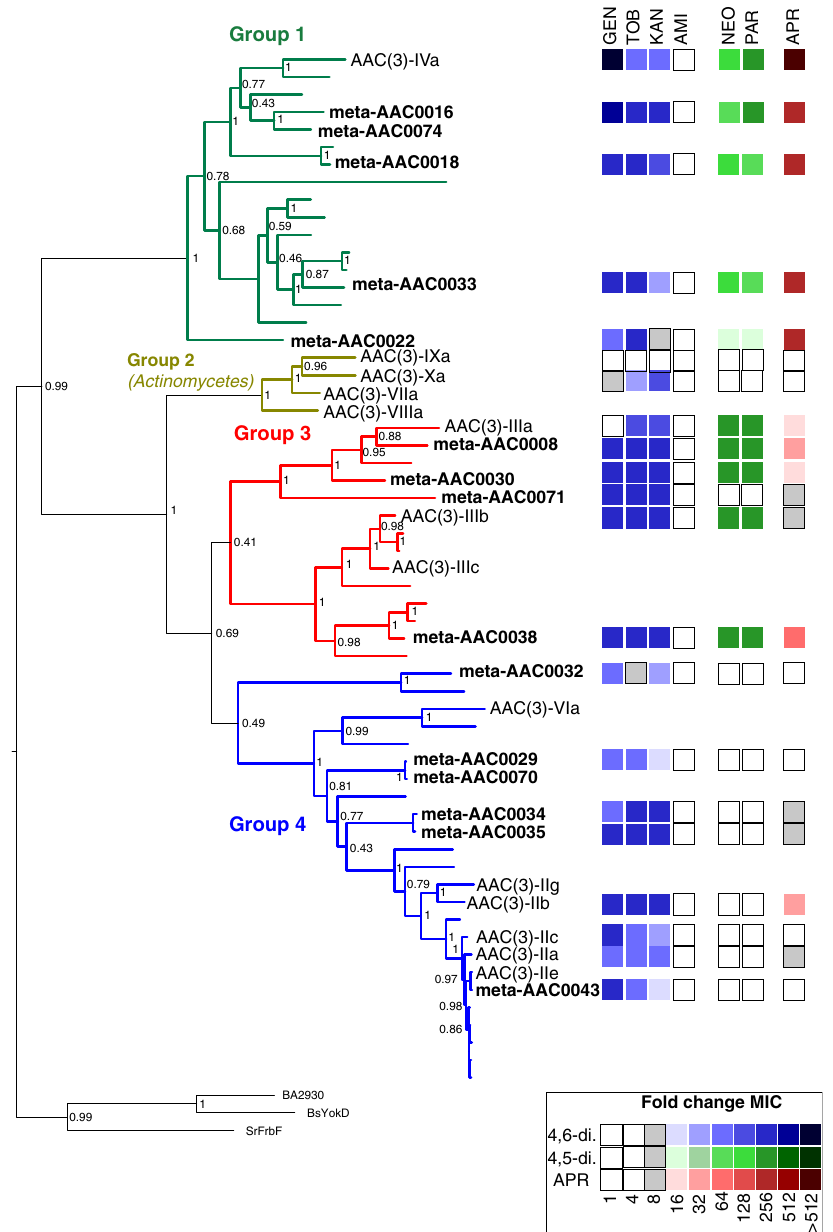
Fig. 2 Family-wide antibiotic susceptibility mapped onto phylogenetic reconstruction of Antibiotic_NAT family. The four main groups are separately colored. Sequence names are only shown for meta-AAC, clinical isolates of AAC(3) enzymes, and outgroup members with Antibiotic_NAT fold but with no activity against aminoglycosides (FrbF, YokD, and BA2930); other sequences not labeled are hits from a BLAST search of NCBI nr database. Node labels are Bayesian probability values. The right side represents a heatmap of AG susceptibility (fold change MIC relative to control strain containing no resistance element), with key shown at bottom right, full data in Supplementary Table